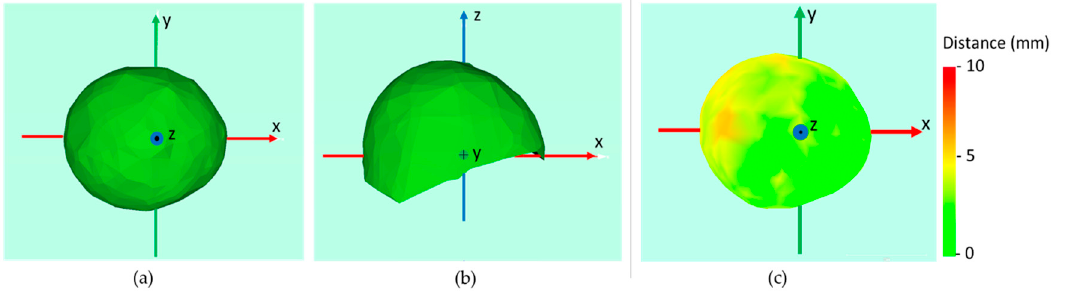
Figure 1. Top ( a ) and lateral ( b ) view of a model registered using CPA plus three tie points. Distances between two models ( c